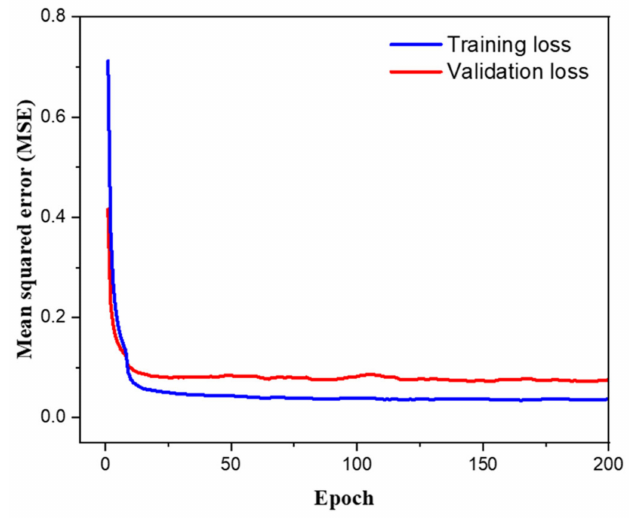
Figure 4. Training and validation loss curves of the ANN over epochs.